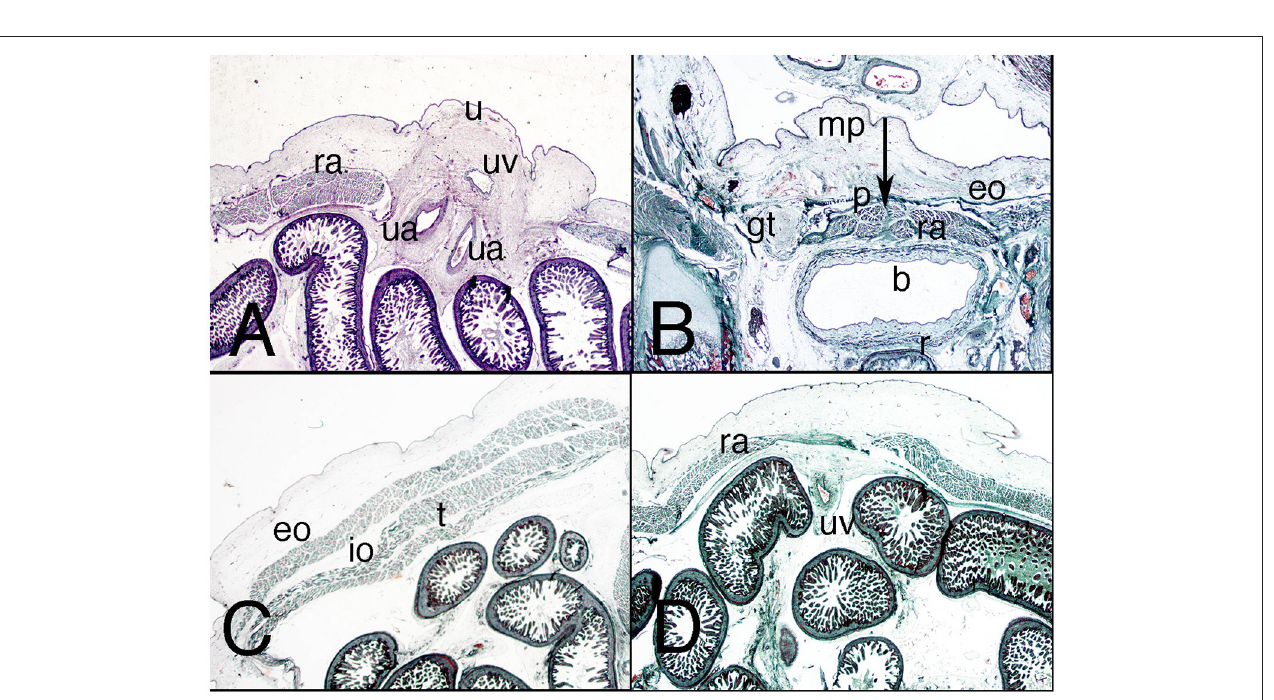
FIGURE 10 | Axial sections of the abdomen in a fetus F-88 (12th week). Trichromic staining. (A) (1X) at the umbilicus region; (B) (2X) section of the inguinal region; (C) (1X) section of the middle third of the lateral abdominal wall; (D) (1X) section of the middle third of the anterior abdominal wall. b, bladder; eo, external oblique muscle; gt, gubernaculum testis; iev, inferior epigastric vessels; io, internal oblique muscle; mp, mons pubis; p, pyramidalis muscle; r, rectum; ra, rectus abdominis; t, transversus muscle; u, umbilicus; uv, umbilical vein. Arrow, linea